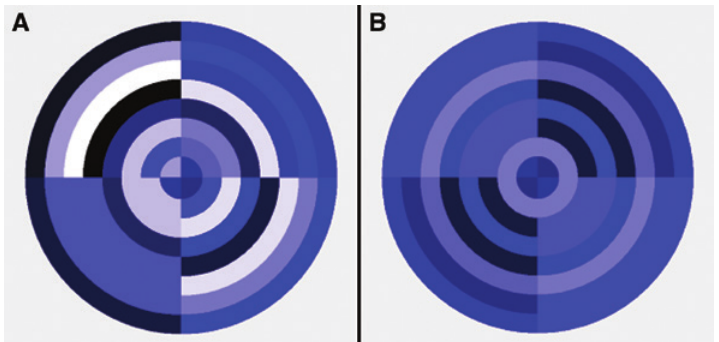
Figure 3: Best Individual from (A) Initial Population and (B) All Generations, for Experiment 2.